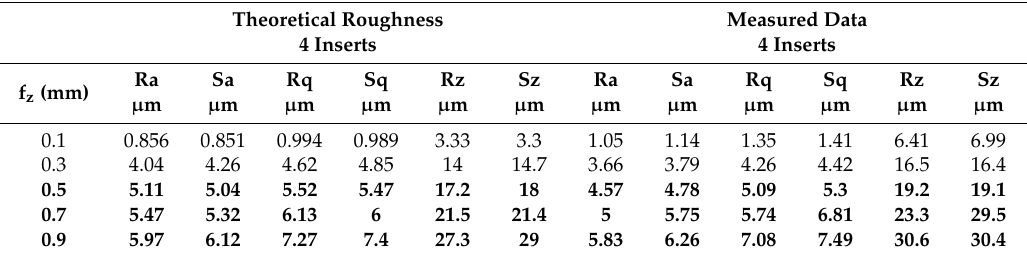
Table 4. Roughness values on surfaces milled by four